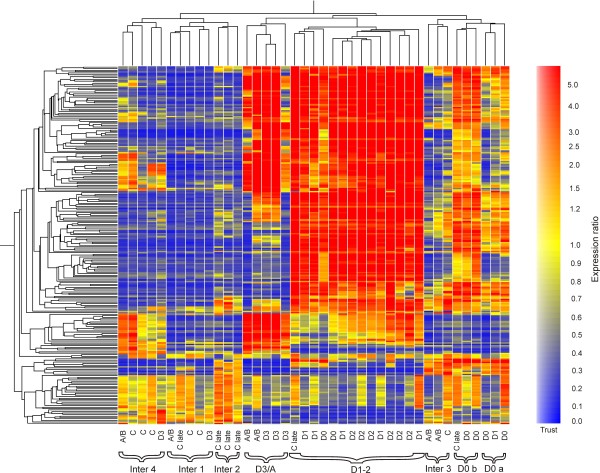
Condition tree of transcripts significantly differentially expressed more than twofold between moult stages (similarity measure: Pearson correlation; clustering algorithm: average linkage). Expression colour bar denotes ratio relative to control.